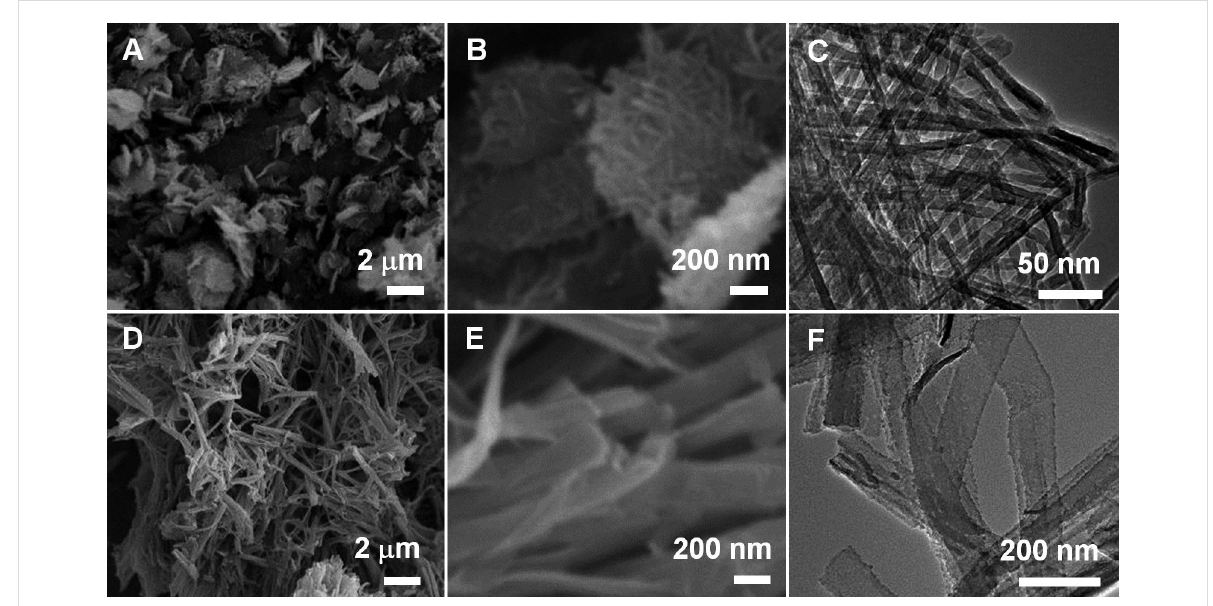
Figure 1: SEM (A, B, D and E) and TEM (C and F) images of silica nanotubes synthesized by alkali-induced room-temperature self-assembly of protonated LPEI (A–C) and silica nanoribbons formed by temperature-induced self-assembly of LPEI (D–F). The LPEI template for the formation